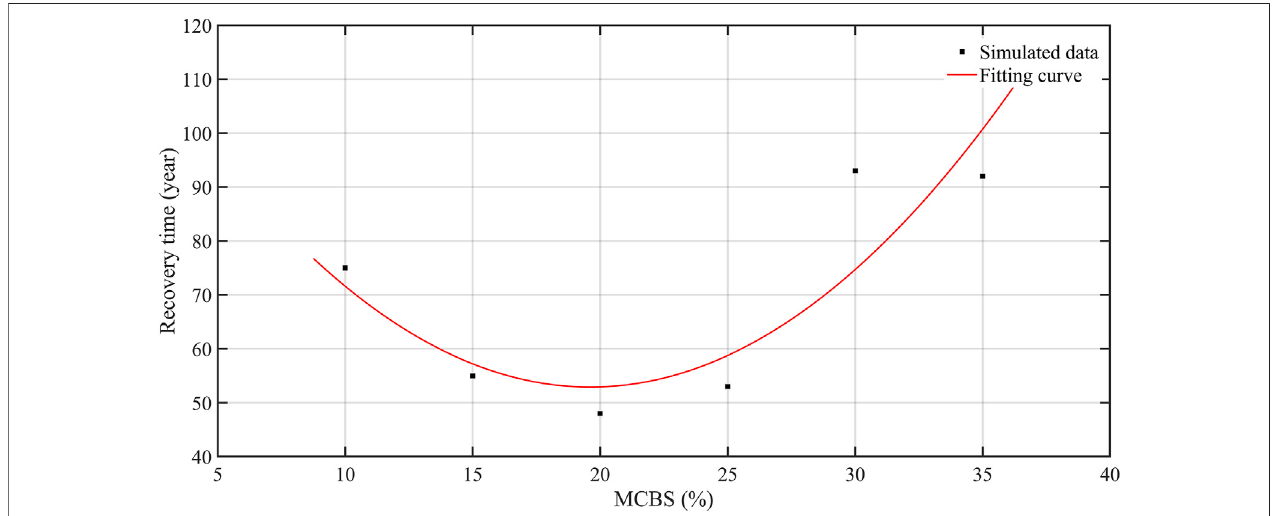
FIGURE 11 | Relationship between soil moisture content (MCBS) and the ground temperature recovery time.